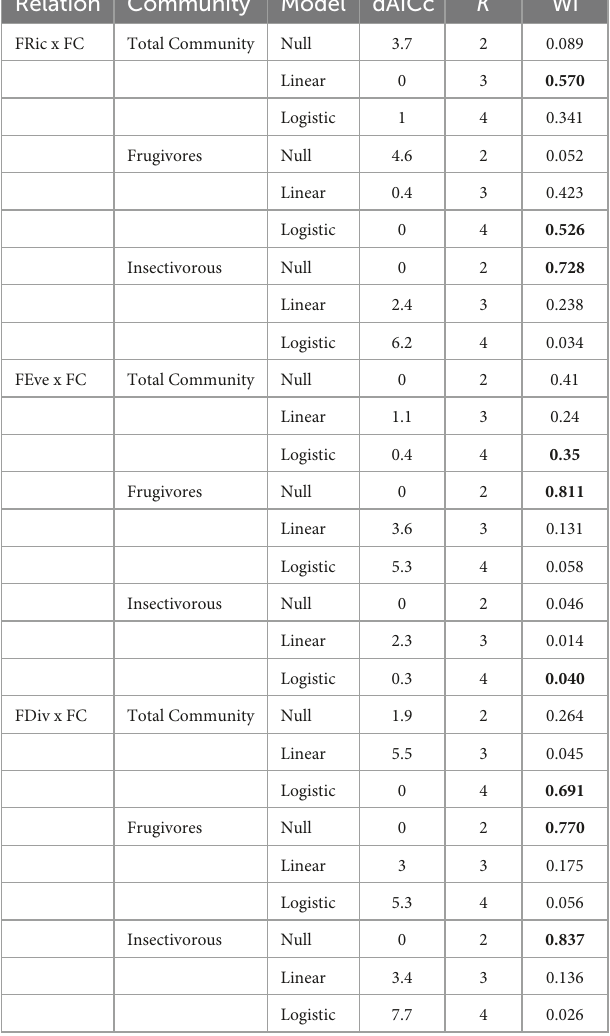
TABLE 2 Model selection of the relation between functional diversity (Fric, FEve, and FDiv) and the forest cover (FC), to different bird communities (total community, frugivores, and insectivorous). dAICc is the difference between the Akaike information criterion value, corrected to small samples (AICc) of the model and the best model; K is the number of the model parameters; Wi is Akaike weight. In bold are the selected models. N = 12 for all analyses. Atlantic Forest of Bahia, Northeast